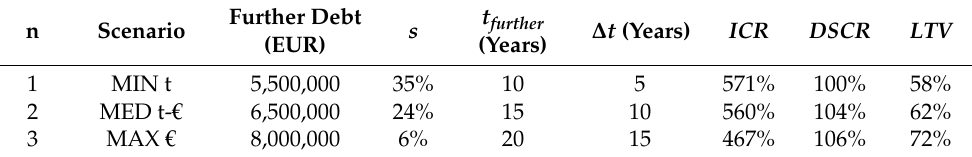
Table 8. Scenario